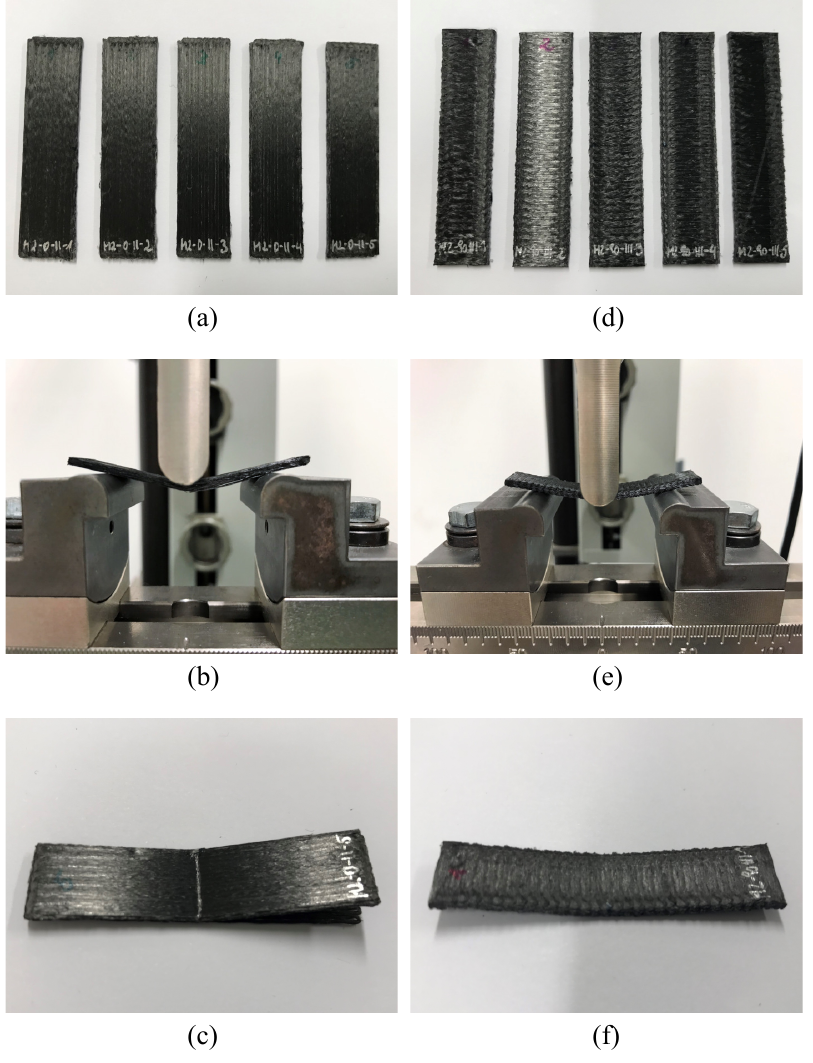
Figure 8. Flexural test specimens before, during and after the three-point bending test. In ( a – c ), specimens with longitudinal fiber direction. In ( d – f ), specimens with transverse fiber